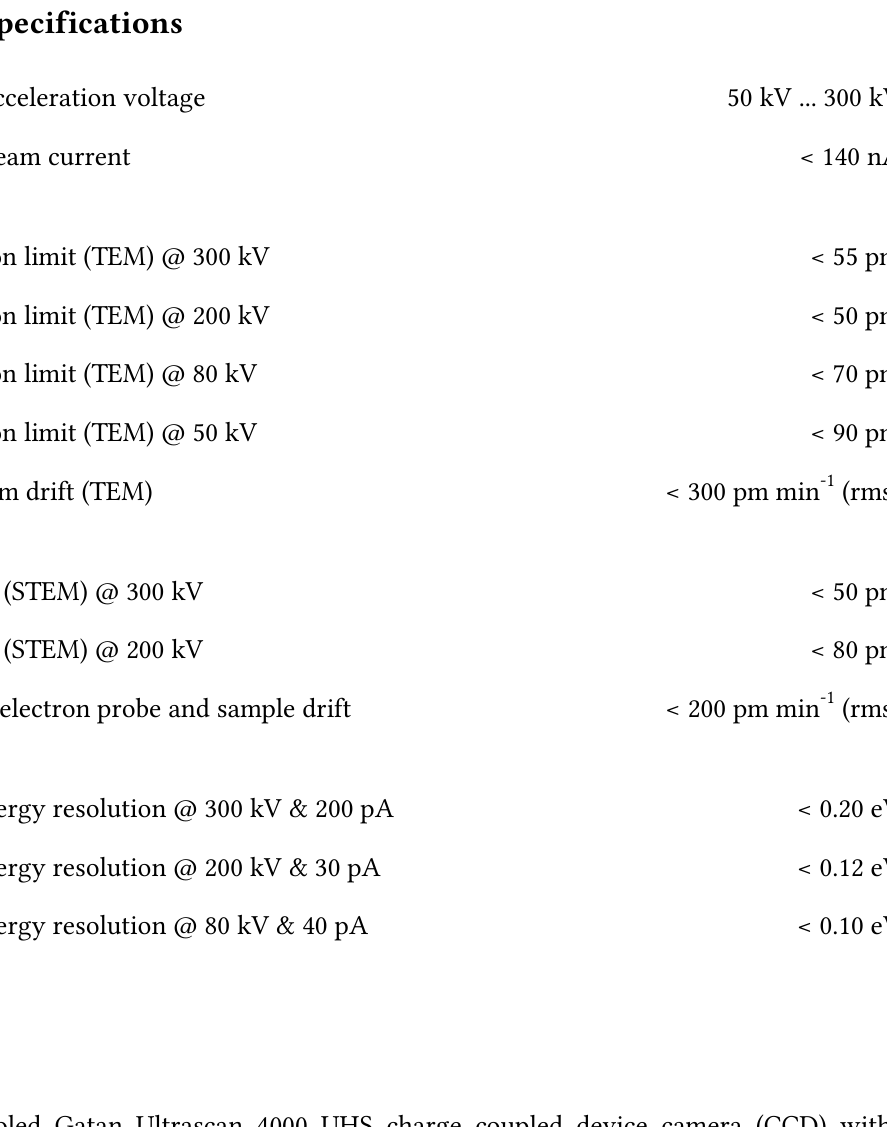
Gatan Quantum 966 ERS image filter (GIF) with fully 2nd and 3rd order and partially 4th order corrected prisms and a maximum field of view of 17 µm for imaging and 120 mR for diffraction analyses, with additional STEM detectors